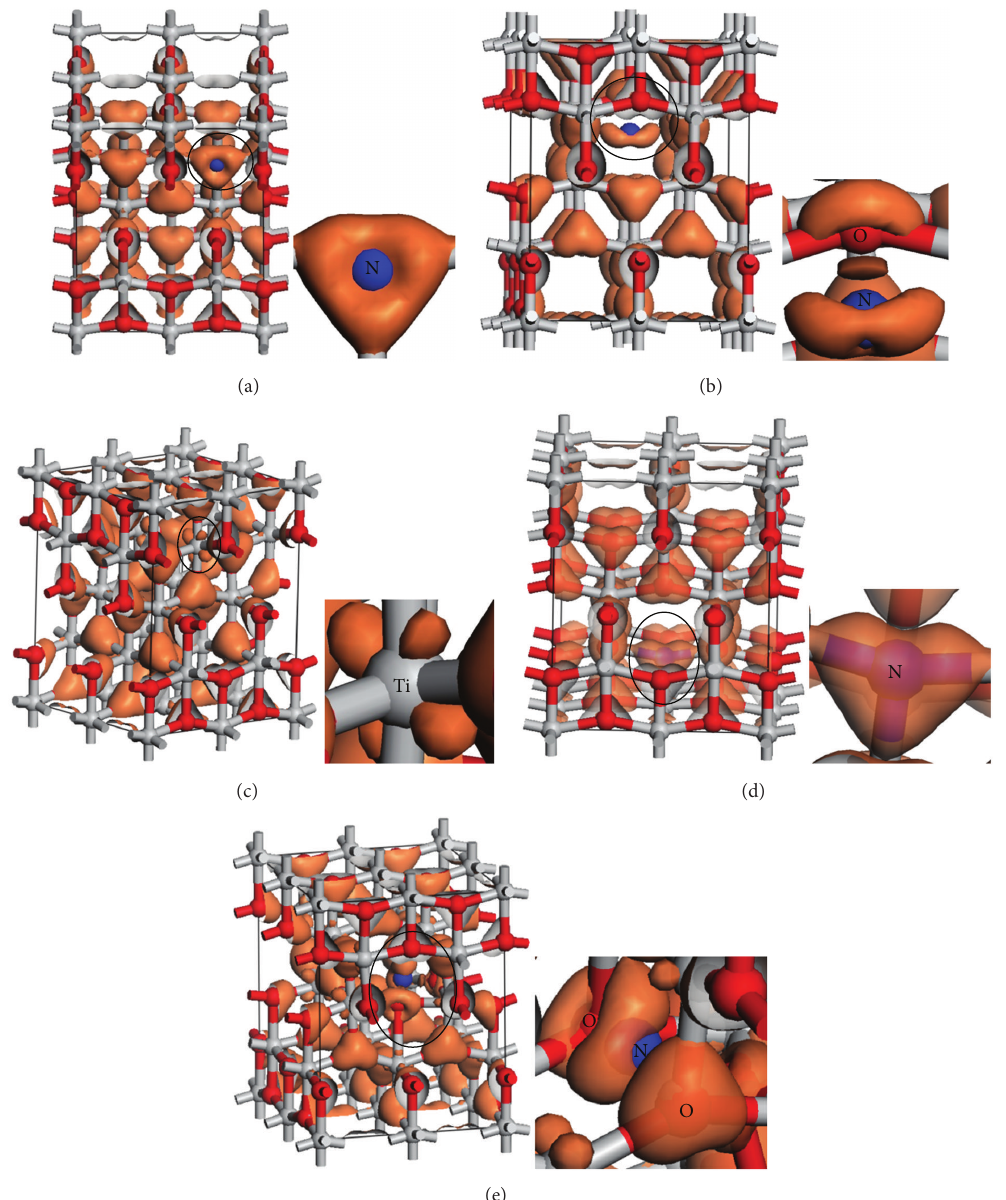
Figure 3: Charge distribution of various defective models in N-doped TiO 2 : (a) N s , (b) N i , (c) O v , (d) N